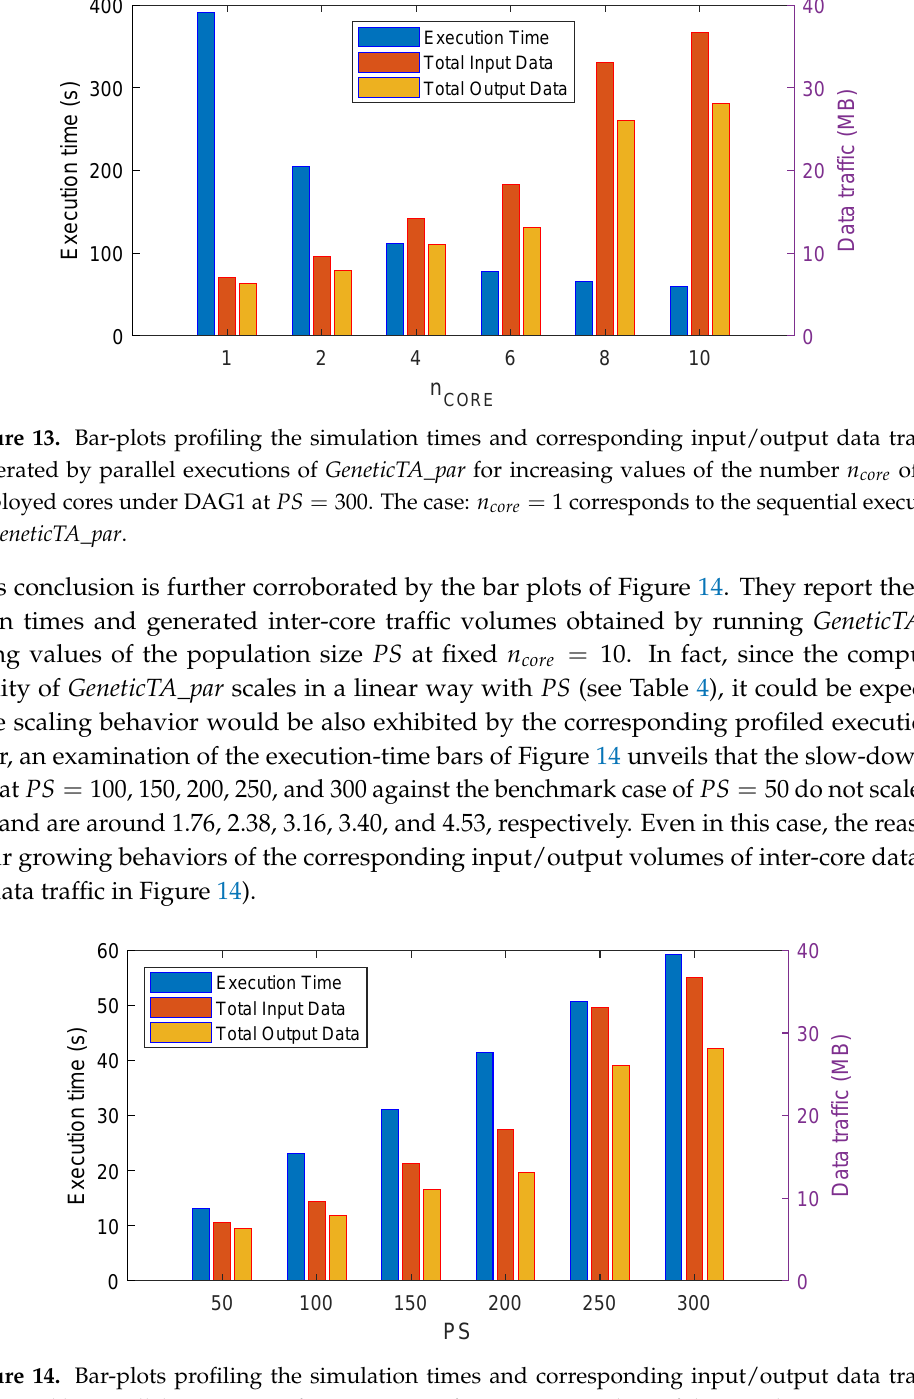
Figure 14. Bar-plots profiling the simulation times and corresponding input/output data traffics generated by parallel executions of GeneticTA_par for increasing values of the population size PS . The case of DAG1 at n core =